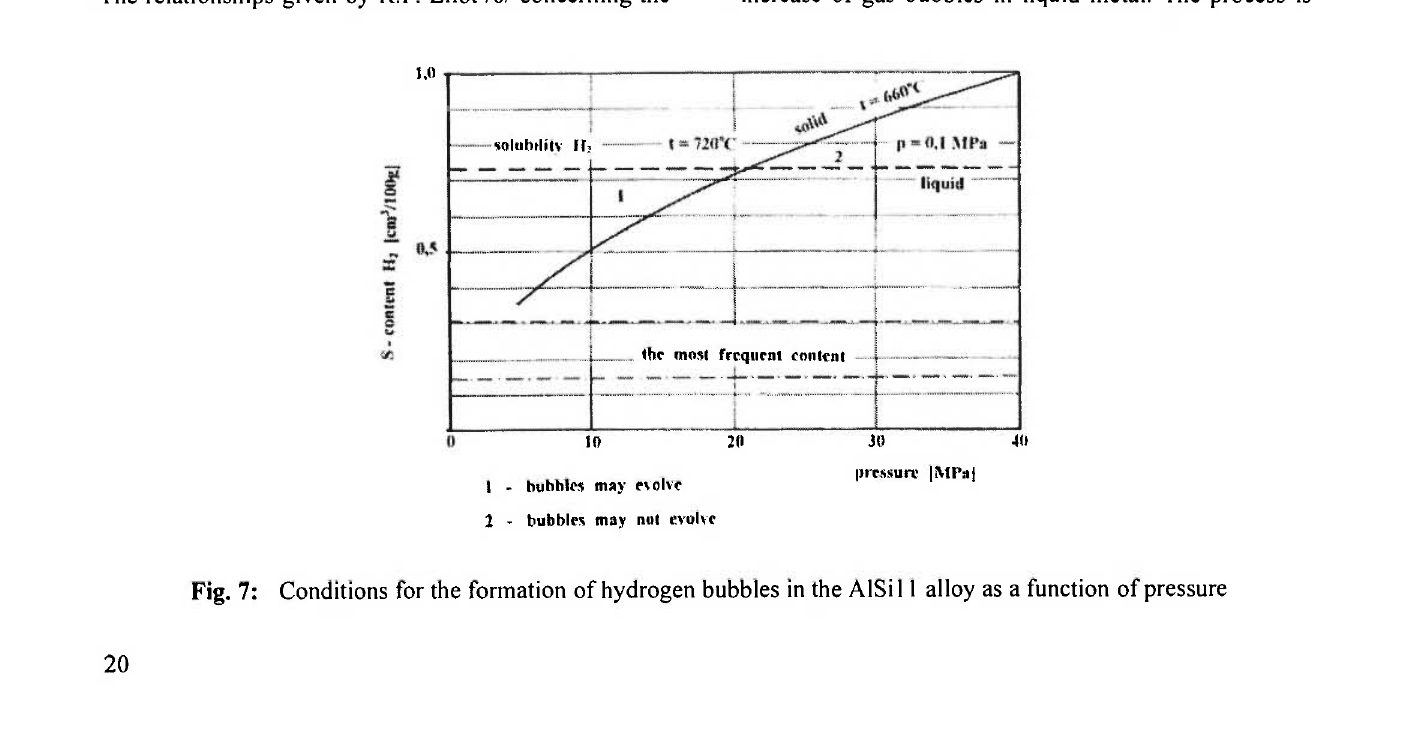
This means that in the extreme case, when the total volume of the gas phase filling reinforcement pores gets occluded by the liquid metal of the infiltrating matrix, the porosity of the obtained composite will increase 0,3+1% depending on the reinforcing component (heated or cold).